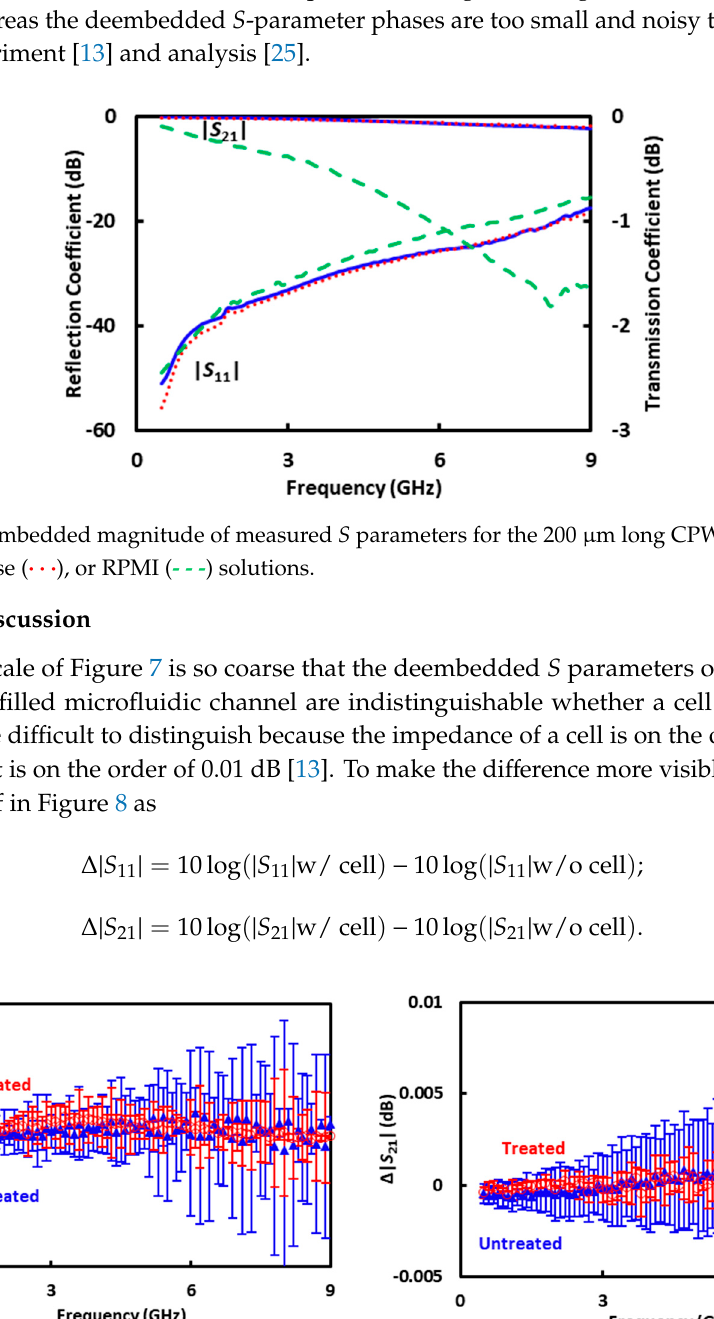
) and untreated ( (cid:78) ) cells (cid:35)